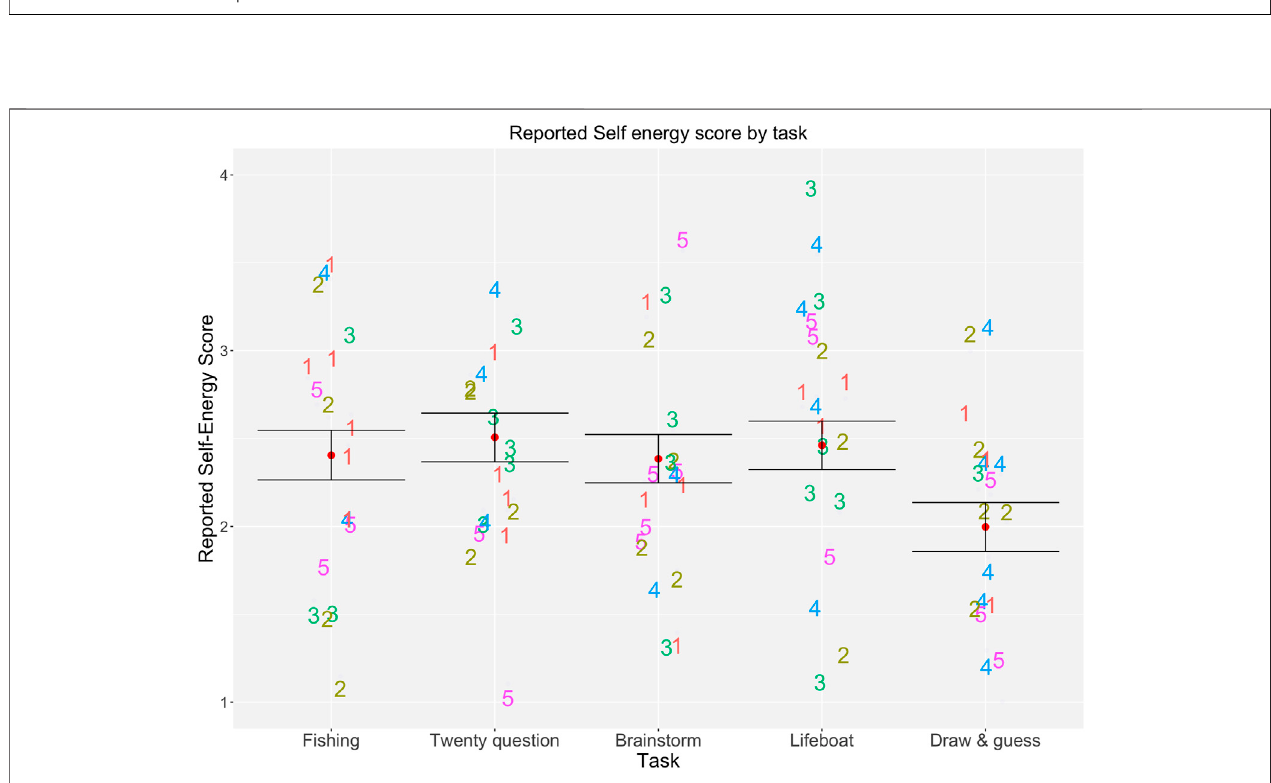
FIGURE5| Energyscorereportedbyparticipantsforallsessions(1:De fi nitely,2:Slightly,3:Slightlynot,4:De fi nitelynot).Reddotsrepresentmeanandblackbars show standard error of the mean (SE). Numbers on the plot shows session number and the position of number shows participant ’ s reported rating of energy level.